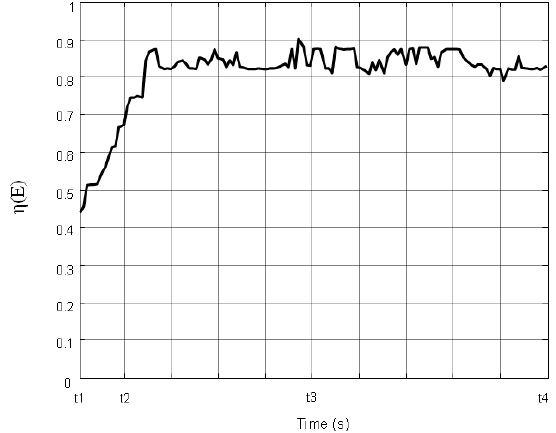
Figure 14. The varying of the coverage efficiency